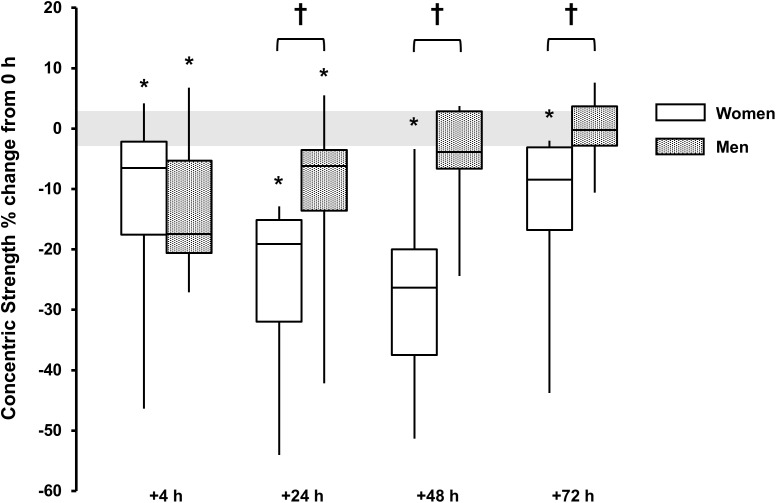
Concentric strength % change from baseline (0 h) between men (gray boxes) and women (open boxes). Boxplot shows median (line) and interquartile range (IQR) (box), whiskers represent the maximum and minimum values. Gray shaded area is the measurement coefficient of variation (CV) (2.9%). The symbol ‘†’ indicates a difference between sexes; The symbol ‘∗’ indicates a difference from 0 h.